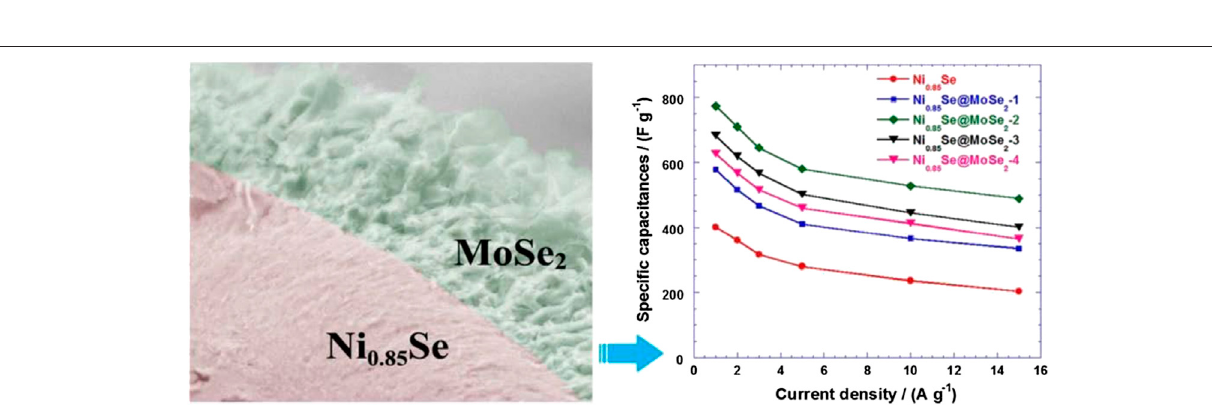
Frontiers in Chemistry |